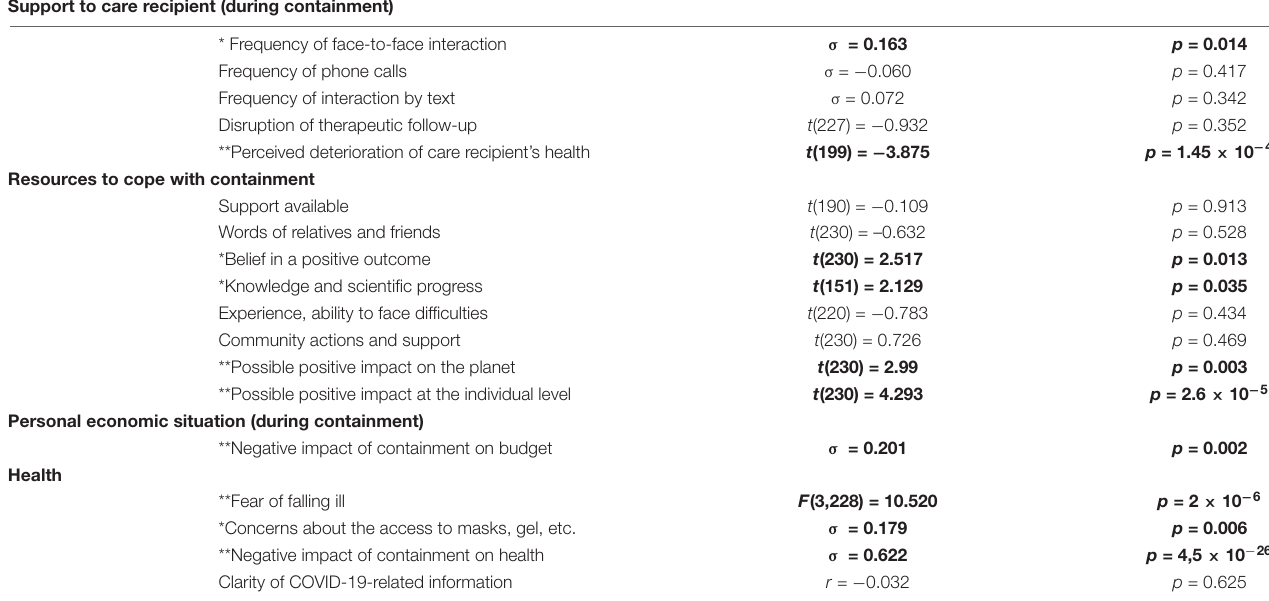
TABLE 2 | List of attitudes and resources of informal caregivers and their association with PSS-10 scores. Support to care recipient (during